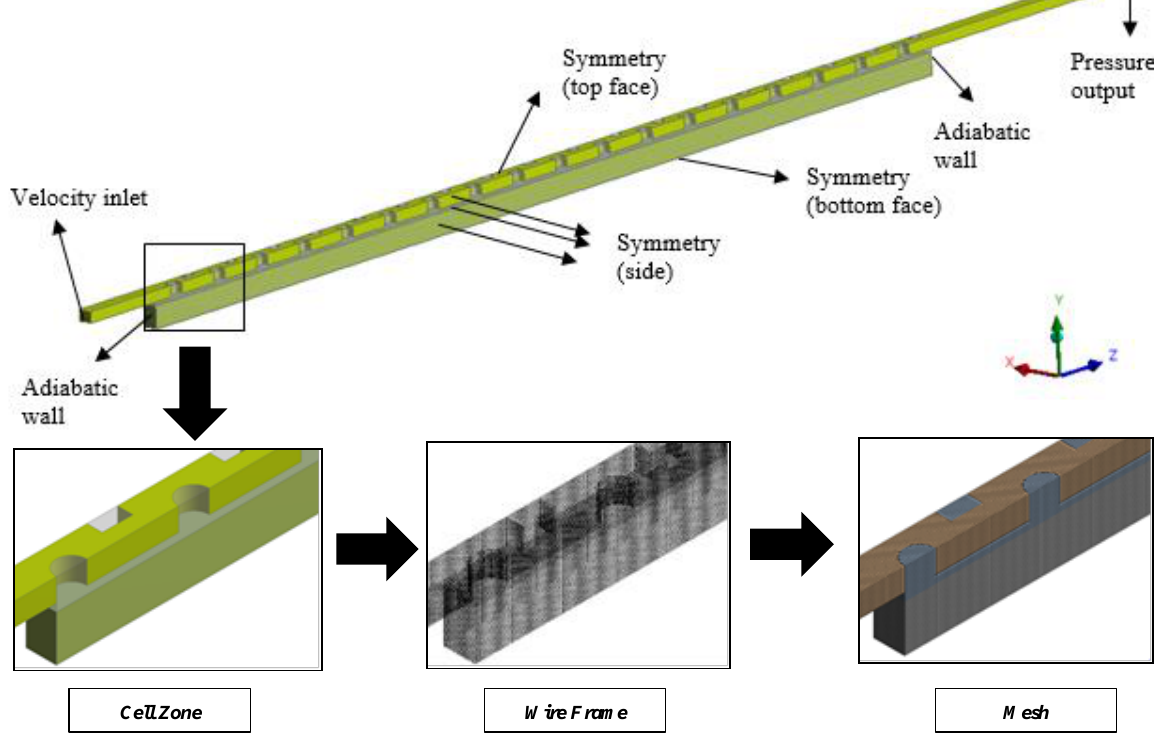
Figure 4. Computational domain